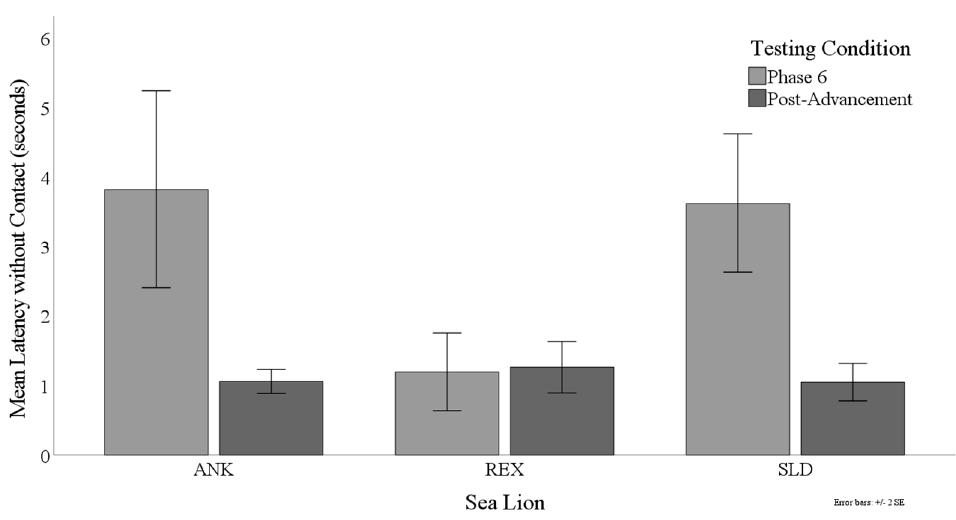
Figure 7. Mean (±2 SE) latency without contact among sea lions and between testing